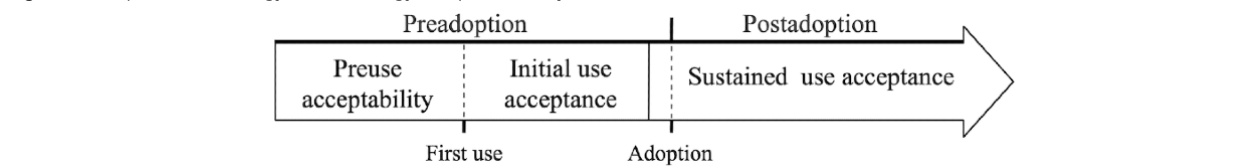
Figure 3. Proposed terminology for technology acceptance